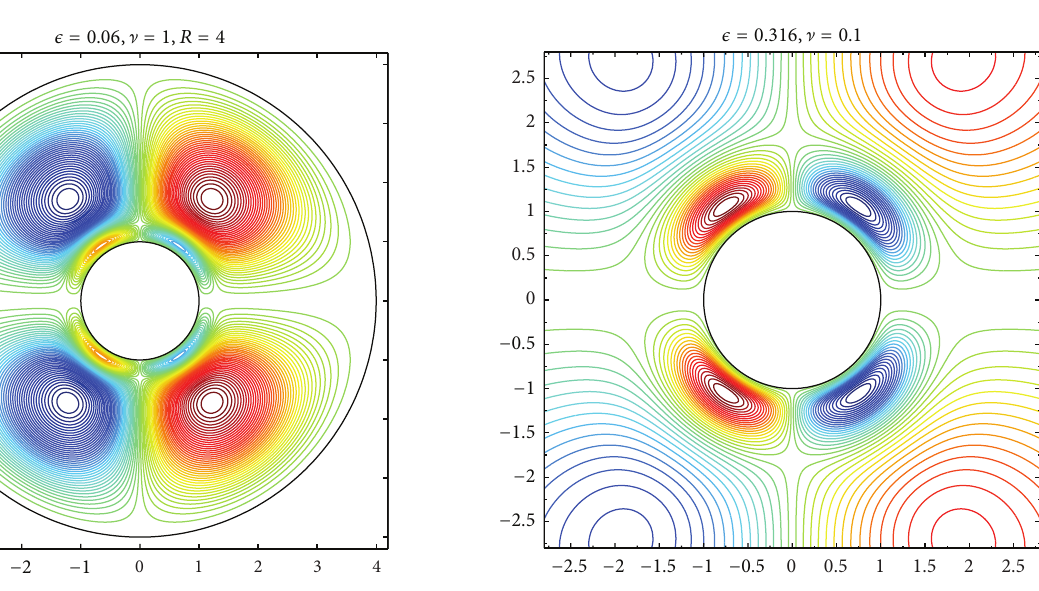
Figure 1: Steady streaming between two spheres. Figure 2: Steady streaming near inner